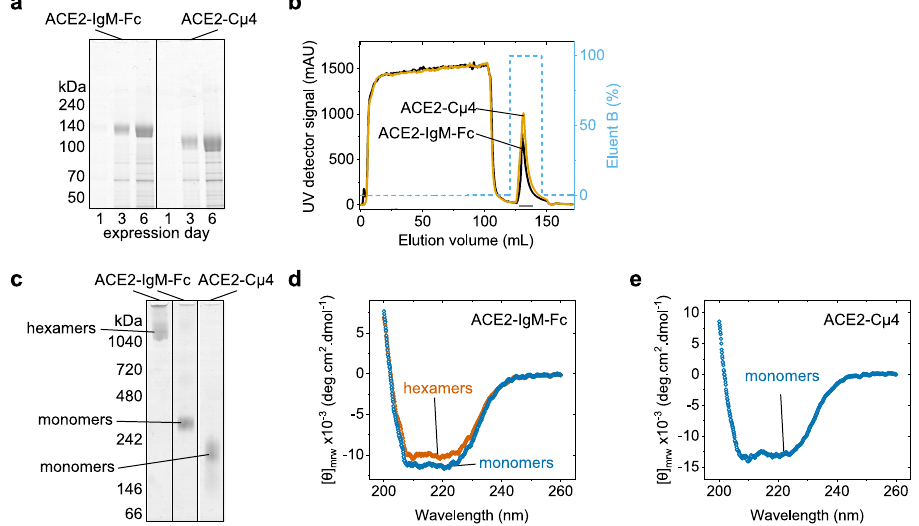
Fig. 1 Expression and structure of ACE2-IgM fusions. a Reducing SDS-PAGE of cell supernatants after transient transfection of Expi293 cells. b Chromatograms from IgM af fi nity puri fi cation of cell supernatants. c Native PAGE of the puri fi ed proteins. d , e FUV CD spectra of the puri fi ed